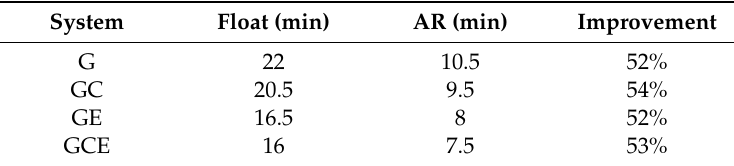
Table 3. Convergence time in the different solutions.